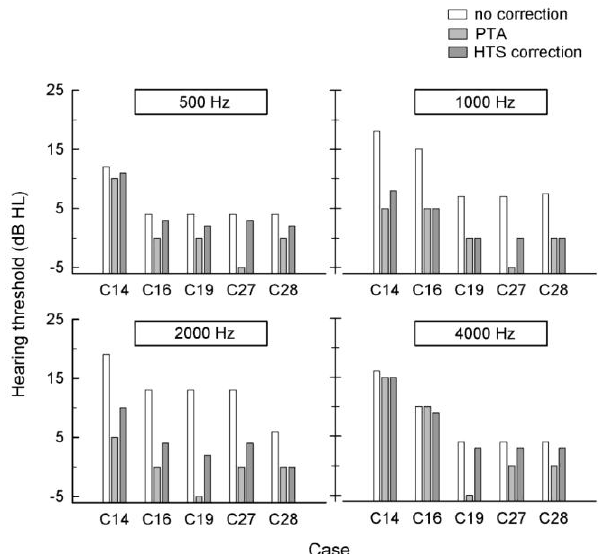
Figure 6. Examples of the performance evaluation of the 500, 1000, 2000, and 4000 Hz tone tests in the presence of 60 dB SPL white noise. White, grey, and dark-grey bars represent the hearing level measured by a smartphone, pure tone audiometry, and a smartphone with the HTS correction algorithm,